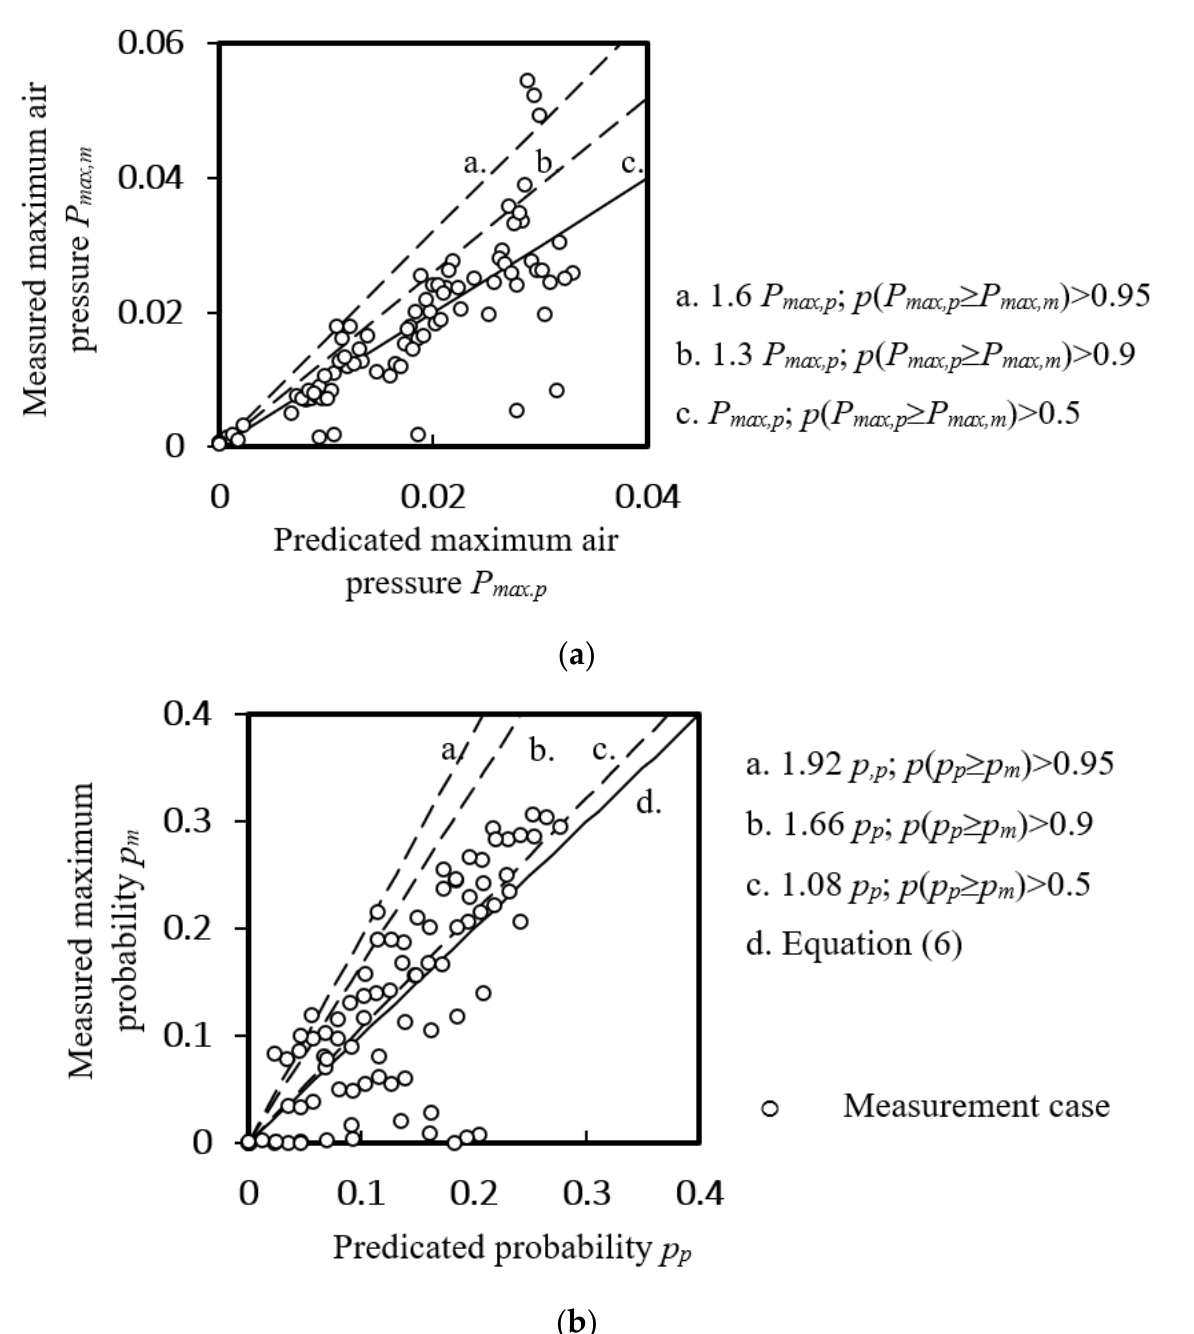
Figure 8. Predicted quantity at Zone A of a discharging drainage stack at H’ ≥ 0.47. ( a ) Maximum air pressure; ( b ) the probability of positive pressure.